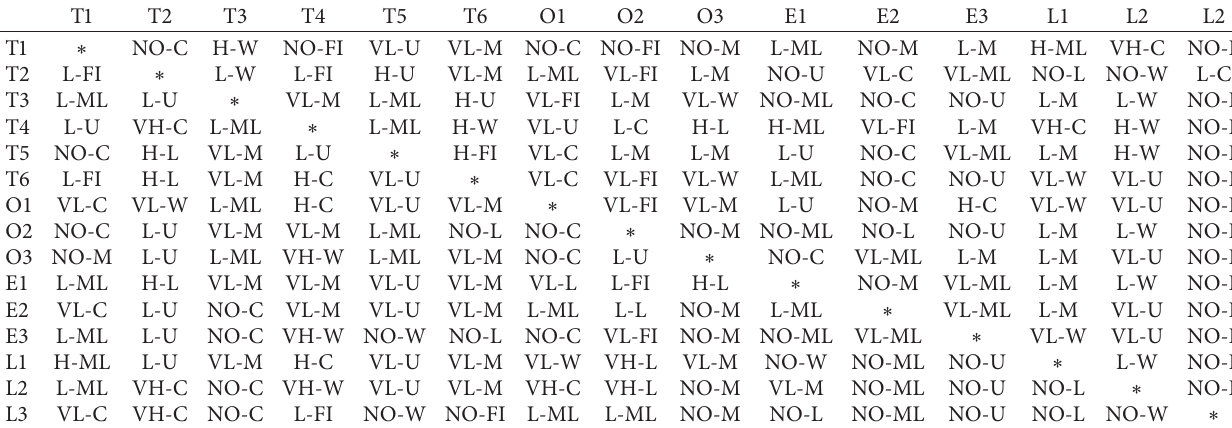
Table 5: Sample of